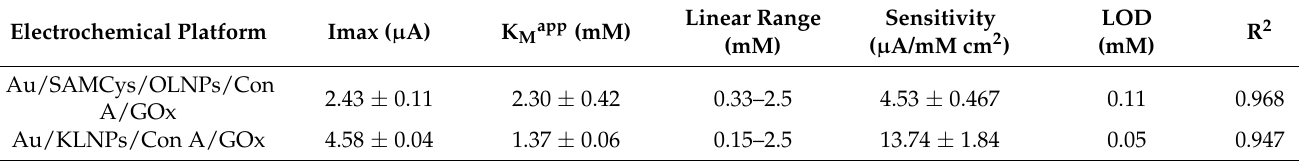
Linear Range Sensitivity LOD R 2 (mM) ( µ A/mM cm 2 ) (mM)